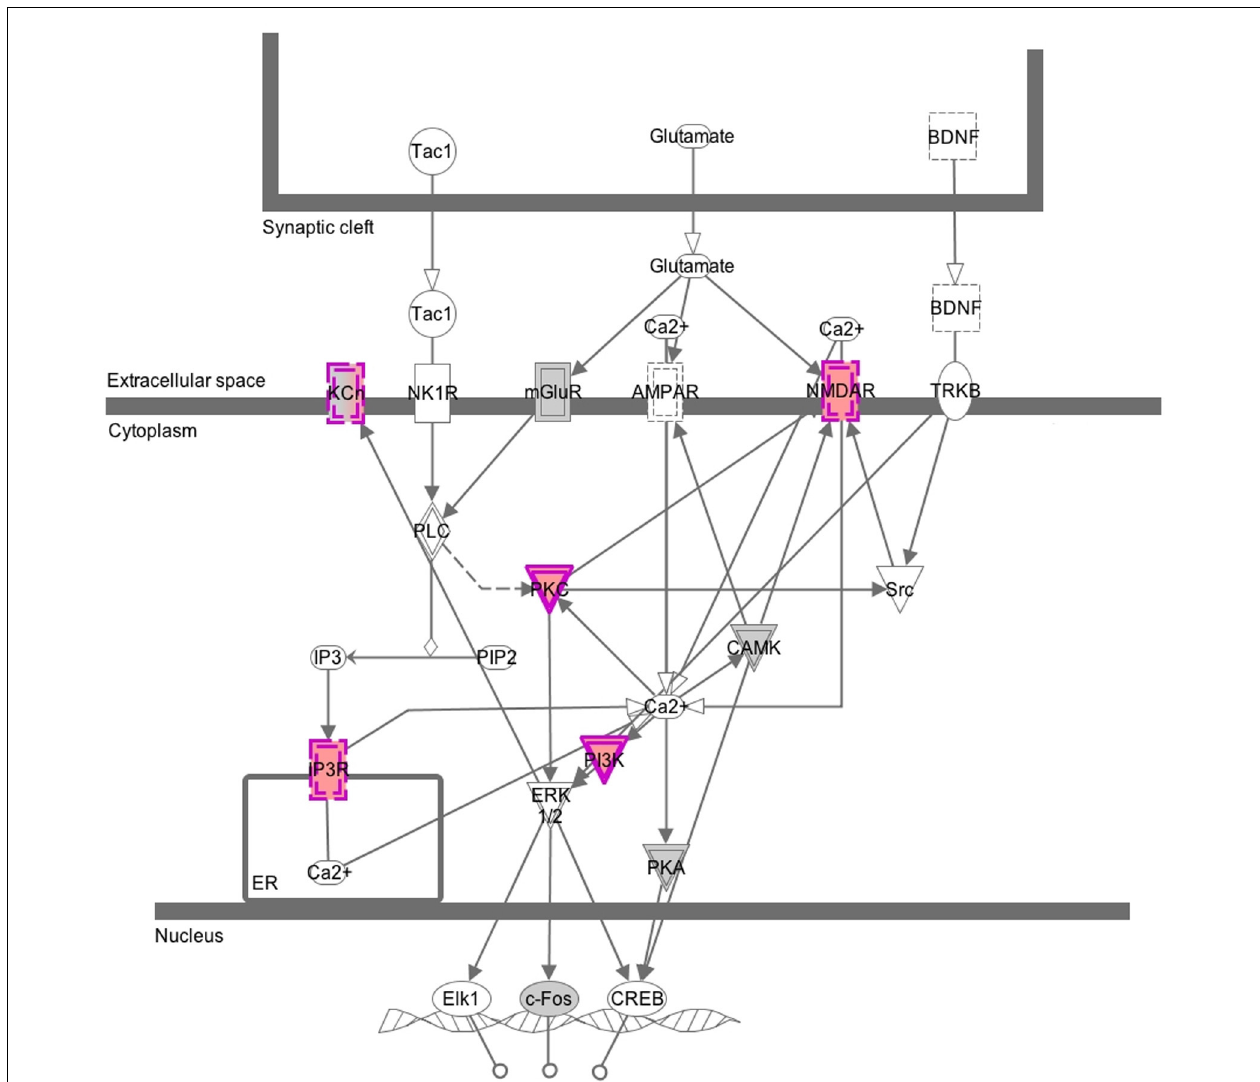
FIGURE 4 | Graphical overview of the Canonical Pathway analysis. This image was generated by Canonical Pathways analysis and shows genes that belong to the category of neuropathic pain signaling in dorsal horn neurons. Nodes in gray and purple depict genes from the CGH